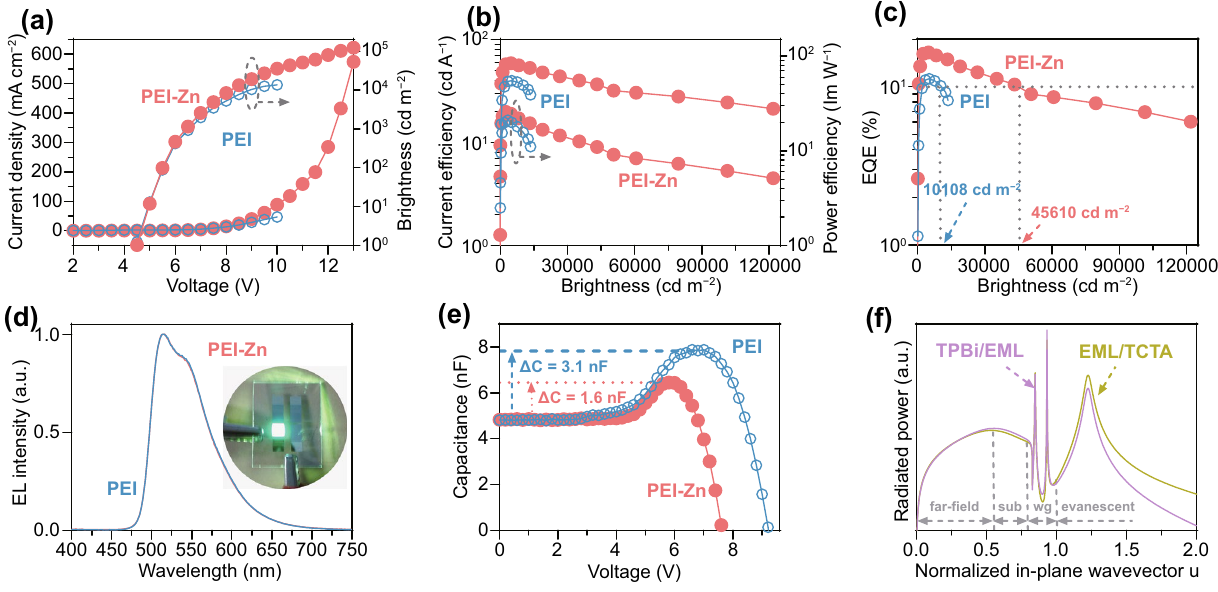
Fig. 3 a Current density–voltage–brightness, b current efficiency–brightness–power efficiency, c EQE–brightness, d EL spectra and e capaci‑ tance–voltage characteristics of device PEI and device PEI‑Zn, f power dissipation spectra of dipole sources at the EML/TCTA interface and the TPBi/EML